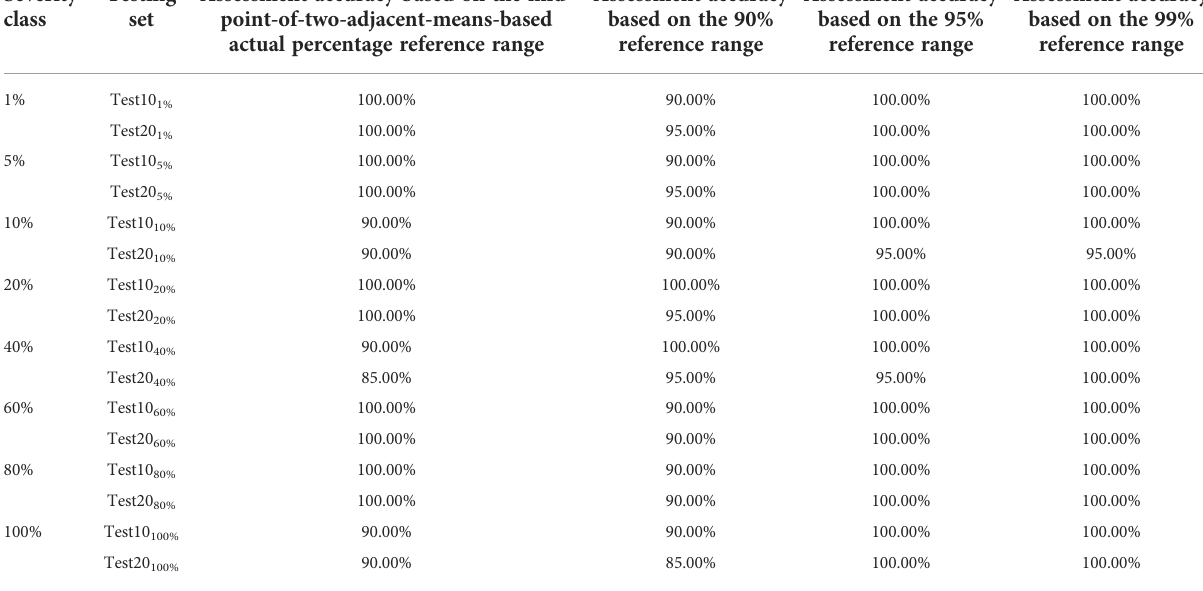
TABLE 5 Severity assessment results of the diseased wheat leaves with the actual percentages of lesion areas contained in each testing set of all the severity classes of wheat stripe rust according to the determined reference